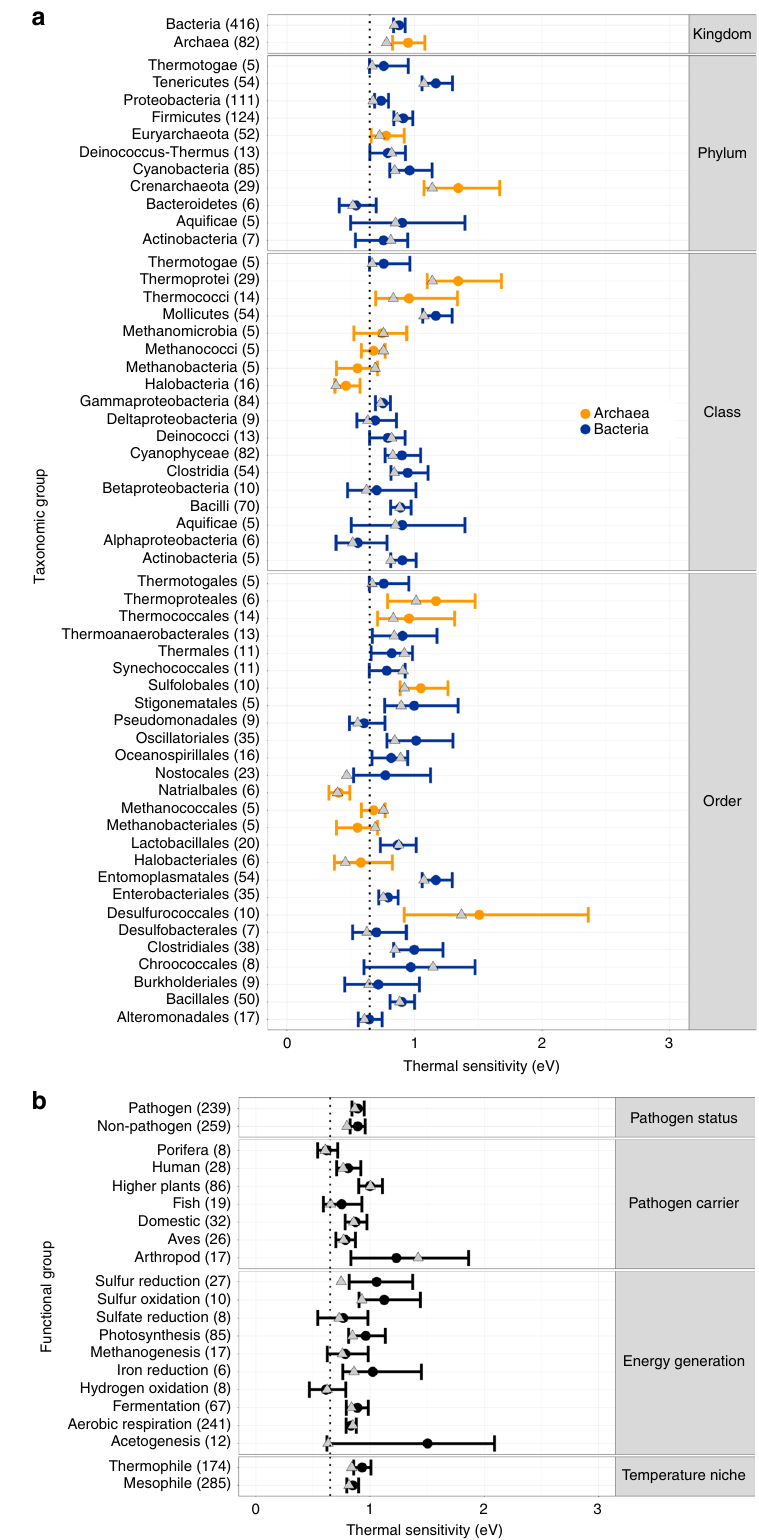
Fig. 4 Variation in thermal sensitivity amongst prokaryotic groups. Comparison of intra-speci fi c population growth rate activation energies ( E S ) across taxonomic levels ( a ) and functional trait groupings ( b ) for archaea (orange) and bacteria (blue). Points and error bars represent weighted mean and 95% CIs of E S for each group. Groups shown are those with at least fi ve data points, the number in brackets indicates the number of data points from which E S was calculated for each grouping. The dotted line marks 0.65 eV, the mean E previously reported within the MTE framework. Grey triangles mark the median E S for each group. Source data are provided as a source data fi